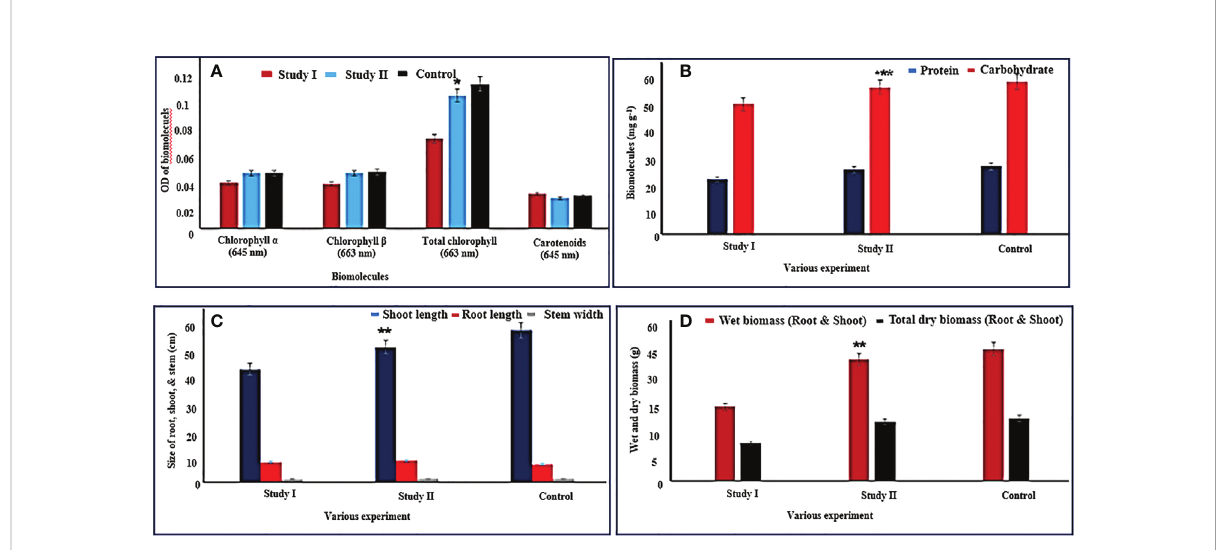
FIGURE 5 Physiological and biomolecule properties of C. cajan ( L .) Millsp. along with and without the amalgamation of B. cereus NDRMN001. The mentioned values are mean and standard error ( ± SE) of triplicates. * Signi fi cantly differs ( p < 0.05), ** and *** signi fi cantly differs ( p < 0.001 and 0.003) from others. (A, B) Biomolecule content of C. cajan ( L .) Millsp. from both study I and II compared with control. (C) Size of root, shoot, and stem of C. cajan ( L .) Millsp. from both study I and II compared with control. (D) Wet and dry biomass of C. cajan ( L .) Millsp. from both study I and II compared with